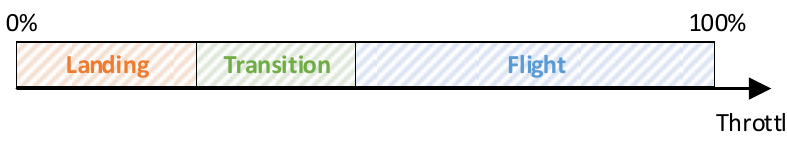
Figure 10. Anti-windup throttle range.